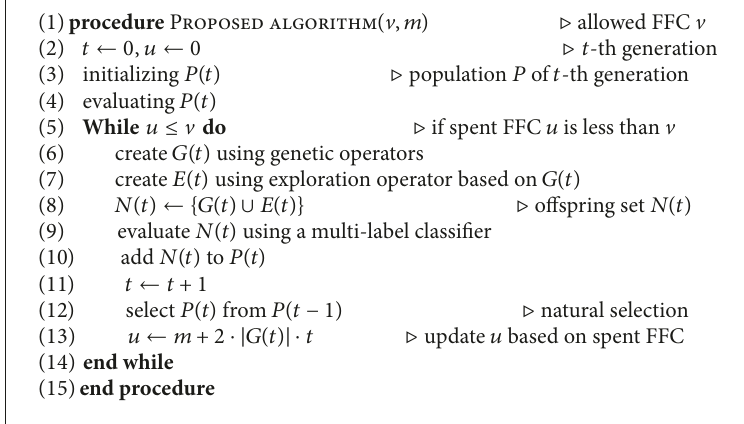
Algorithm 1: Procedures of proposed multilabel feature